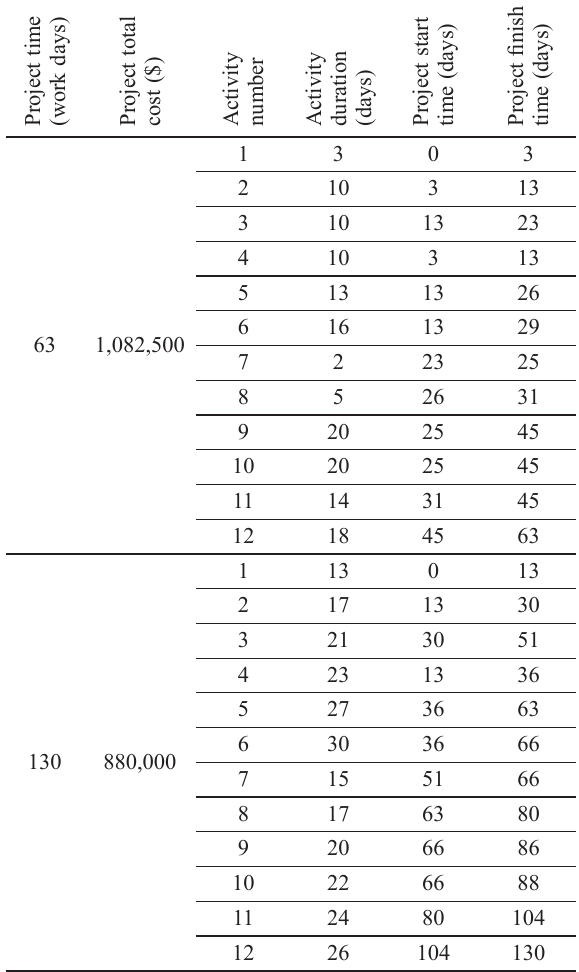
Table 5. Project shortest and longest